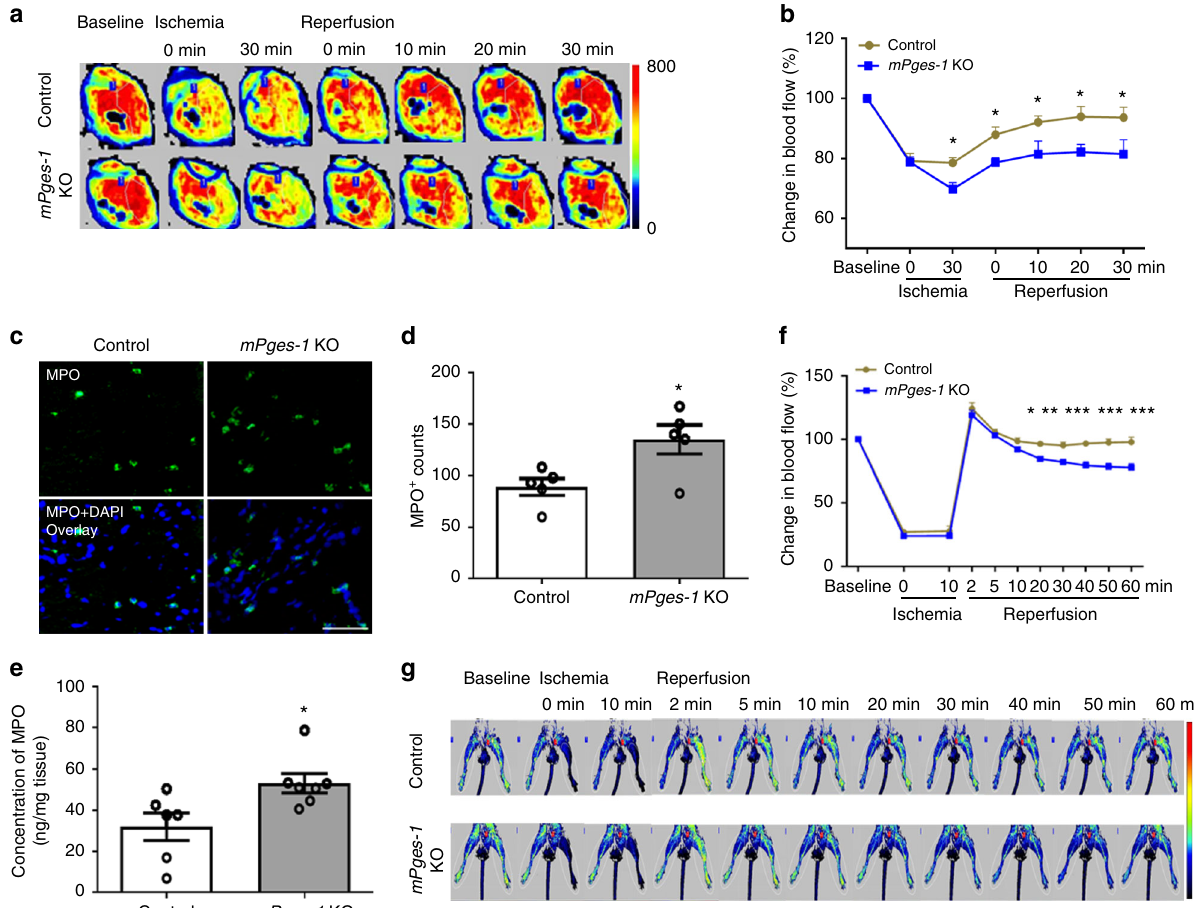
Fig. 3 Essential role of mPGES-1 in preserving microcirculation during I/R. Cardiac microvascular perfusion (percentage change relative to baseline) was recorded at indicated time points before and after release of coronary ligation in mPges-1 WT and KO mice, as detailed in the Methods. Representative perfusion images at each time point were shown ( a ). Relative change in blood fl ow was analyzed ( b ). Immuno fl uorescent staining of myeloperoxidase (MPO, in green) was carried out on the heart sections, and representative photos were shown ( c ). MPO-positive cells ( d ) and tissue levels of MPO ( e ) in the ischemic area were quanti fi ed. Distal microvascular perfusion was also measured during hindlimb I/R. Microvascular fl ow relative to baseline was recorded at indicated time points before and after release of the artery ligation ( f ), with representative perfusion images at each time point shown ( g ). At the baseline before ischemia, no difference in cardiac perfusion (514 ± 13 vs 526 ± 18 PU, n = 17, 14, unpaired Student ’ s t test) or in hindlimb perfusion (86 ± 6 vs 90 ± 4 PU, n = 5, unpaired Student ’ s t test) was observed between control and mPges-1 KO. Two-way ANOVA with Bonferroni ’ s test ( b , n = 12, 11; f , n = 5). Unpaired Student ’ s t test ( d , n = 5; e , n = 6, 7). Scale bar is 50 μ m. Error bar indicates